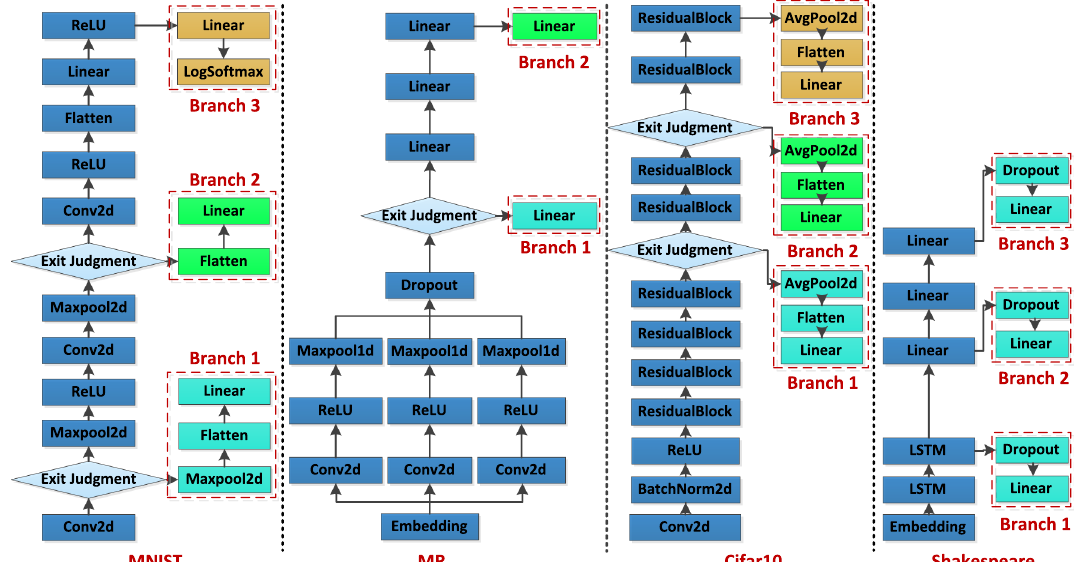
Fig. 3 The model structures of MNIST, MR, Cifar10, and